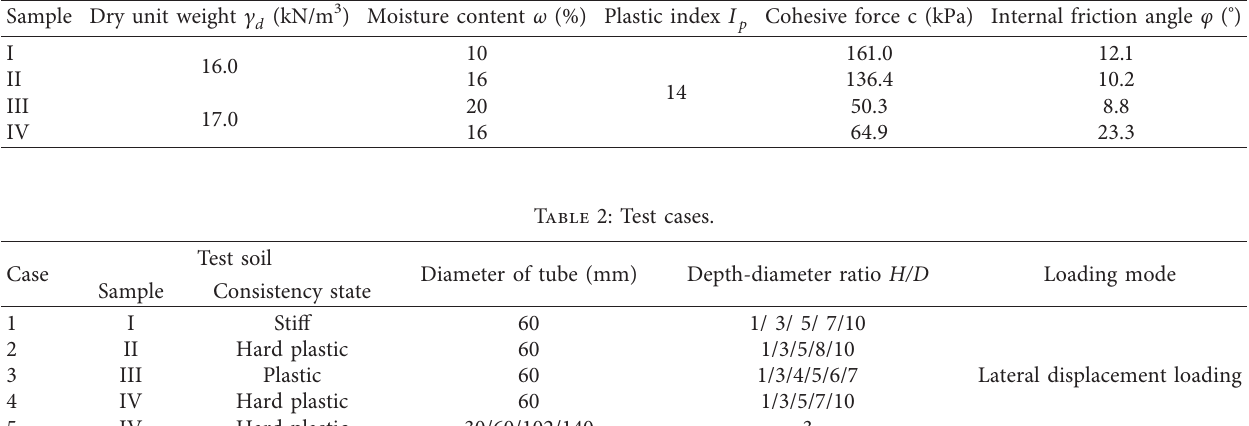
Figure 3: Connection between the steel strand and the test pipe. (a) Fixing device of the steel strand on the test pipe. (b) Schematic diagram of the fixed steel strand. Table 1: Parameters of soil property.